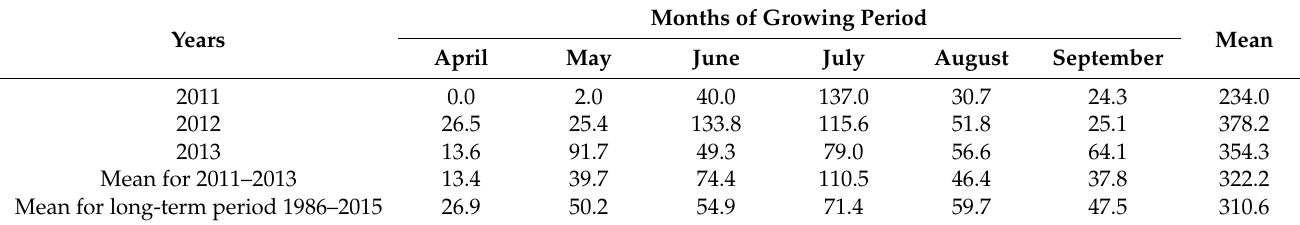
Table 3. Rainfall (mm) data during the growing periods of ‘Courage’ potato (2011–2013).